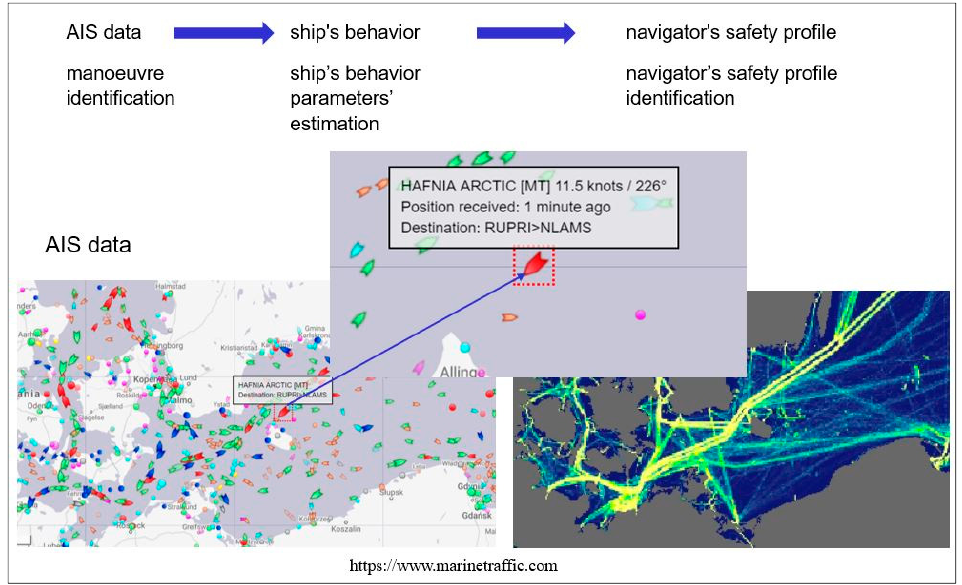
Figure 1. Navigator’s real behavior for his / her profile determination to use automatic identification system (AIS) data.